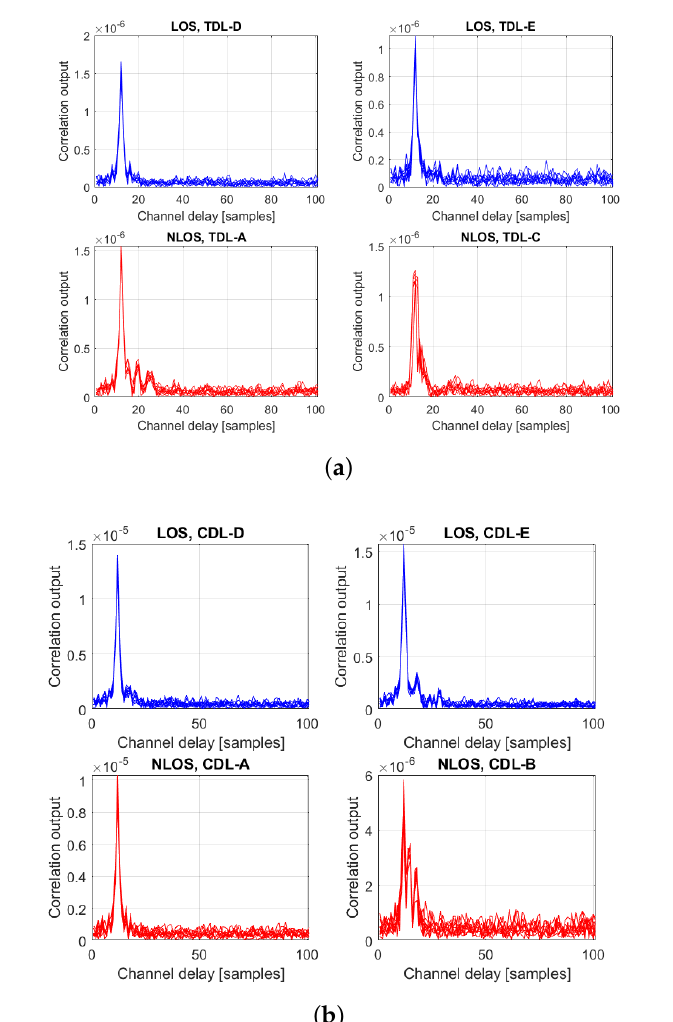
Figure 4. Examples of correlation outputs for PRS signals with various ( a ) TDL and ( b ) CDL channels; 10 random realizations/channel at fixed SNR of 0 dB. Each of the sub-plots corresponds to one of the A to E variants in TDL and CDL. Blue curves are for LOS channels and red curves for NLOS channels.